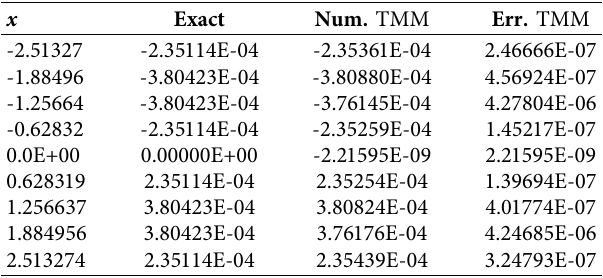
Figure 2: The error of Cauchy kernel at time. T Table 3: Describes the numerical solution of equation (1) with the Hilbert kernel and the corresponding error.